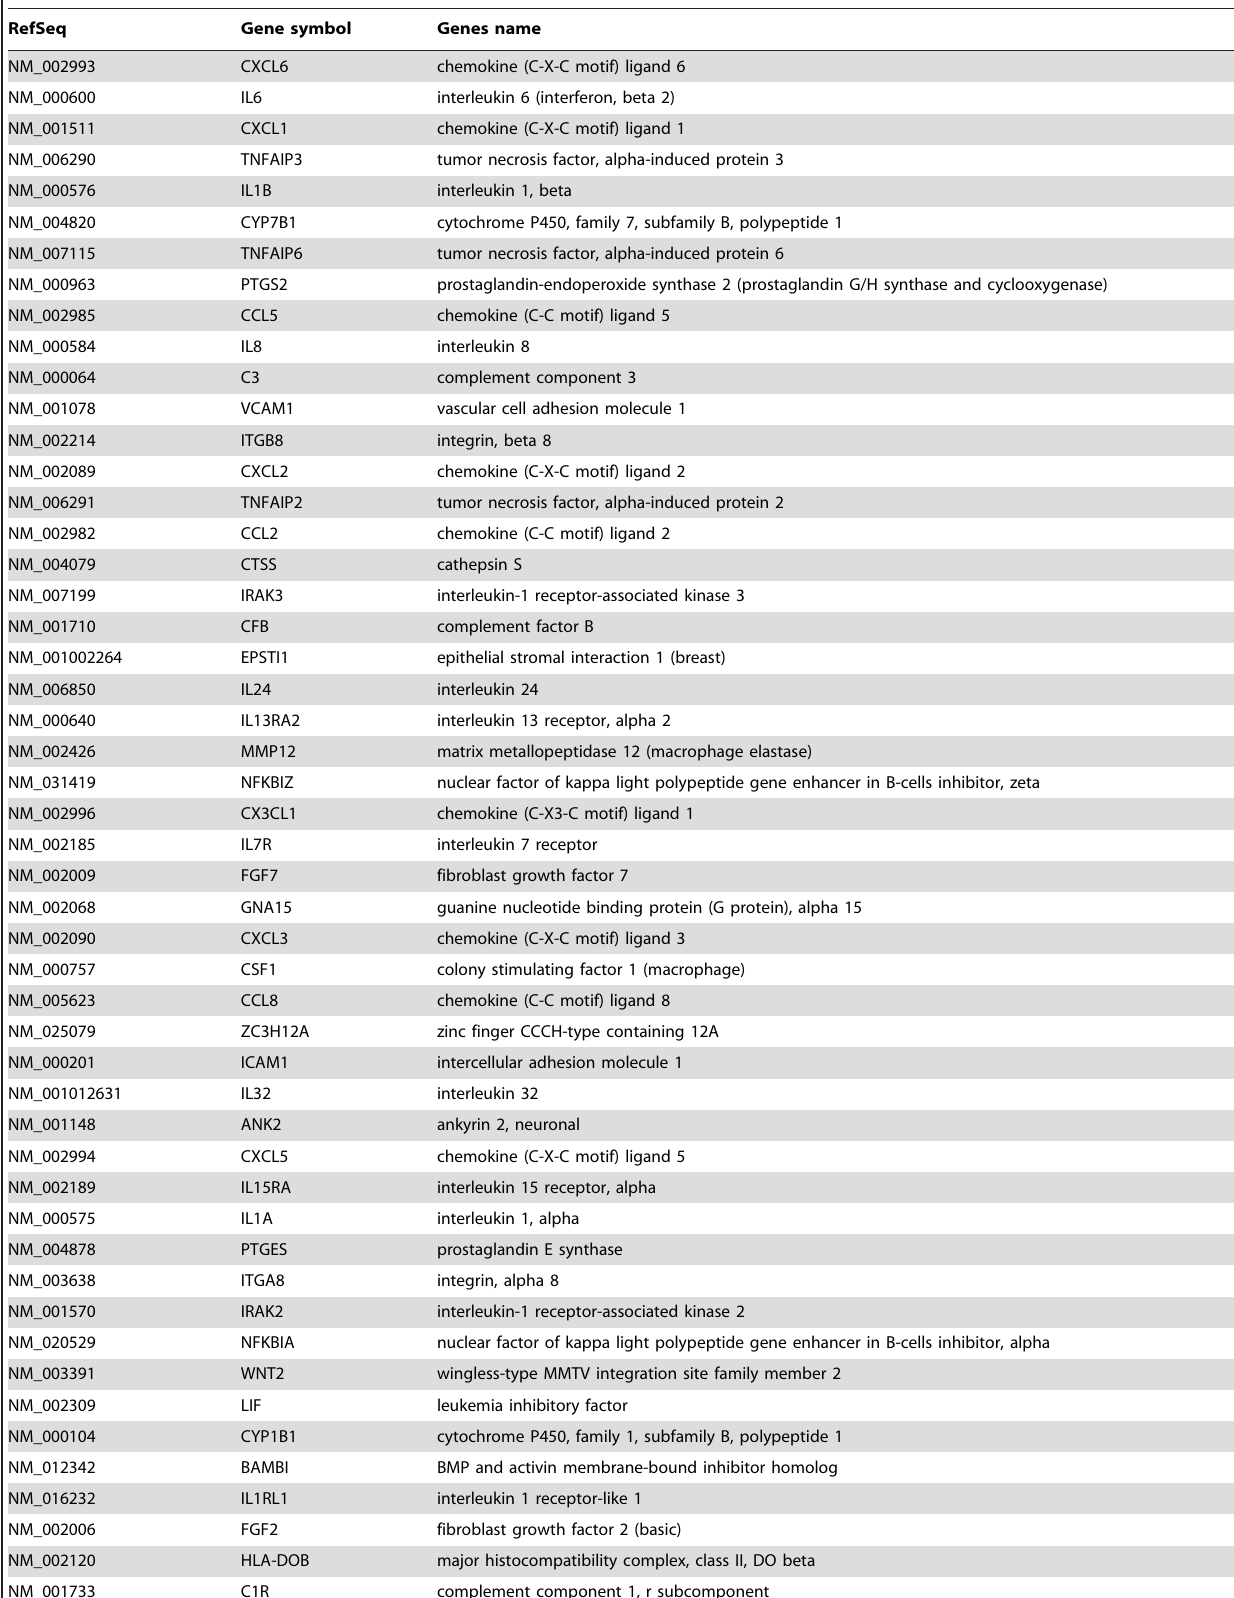
Table 3. Name of up-regulated genes.